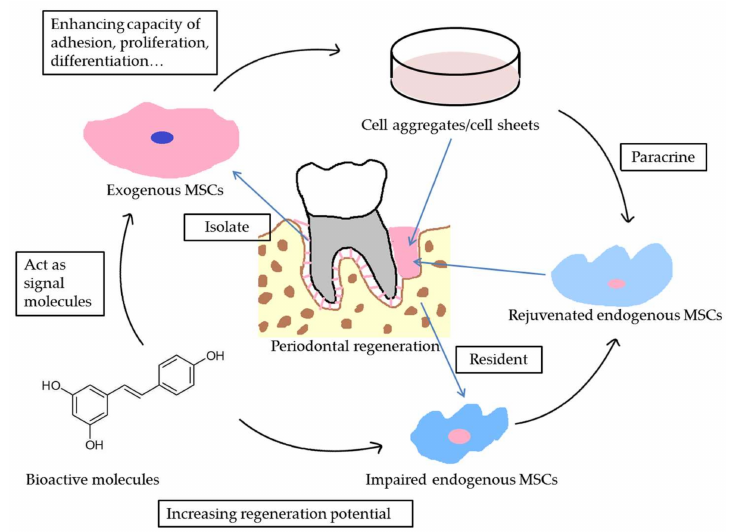
Figure 2. A schematic diagram of the contributions of bioactive molecules in stem cell-based periodontal regeneration. The bioactive molecules could act as signal molecules enhancing the vitality of both endogenous and exogenous MSCs, increasing the regeneration potential of cell aggregates/cell sheets and facilitating periodontal